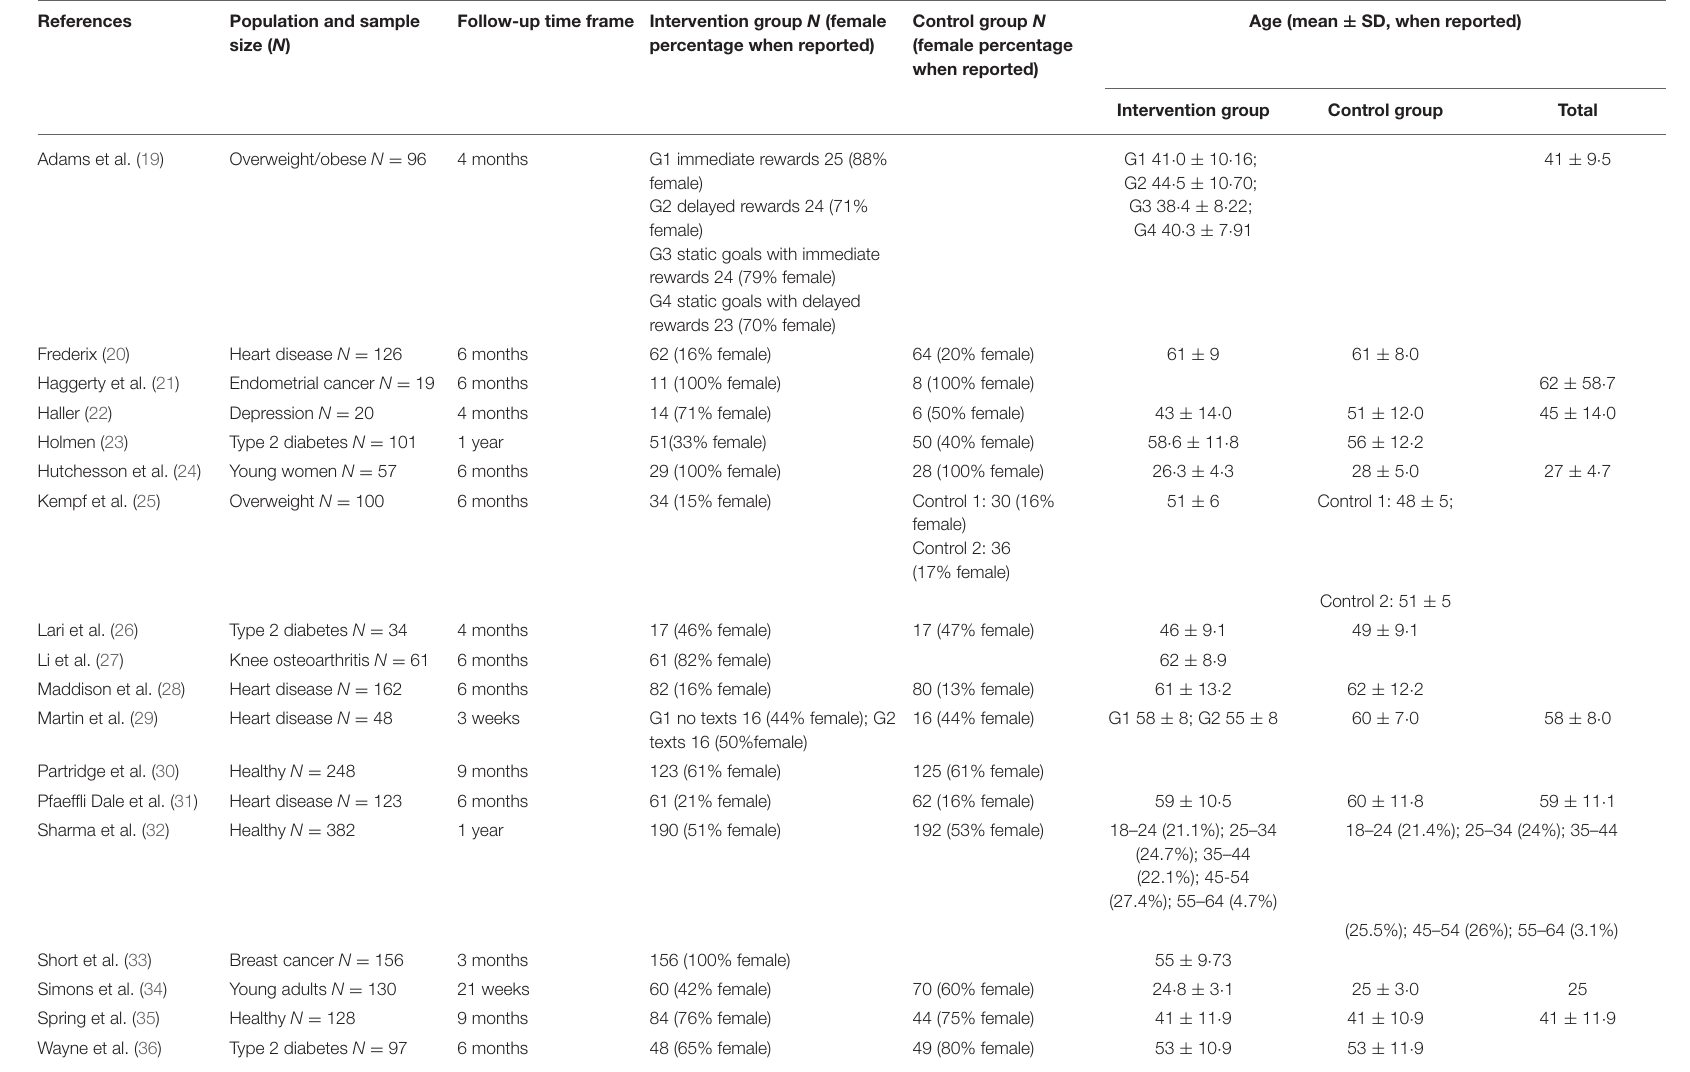
TABLE 2 | Population data of the 18 randomized control trials that report behavior change techniques used in digital health interventions for reducing sedentary